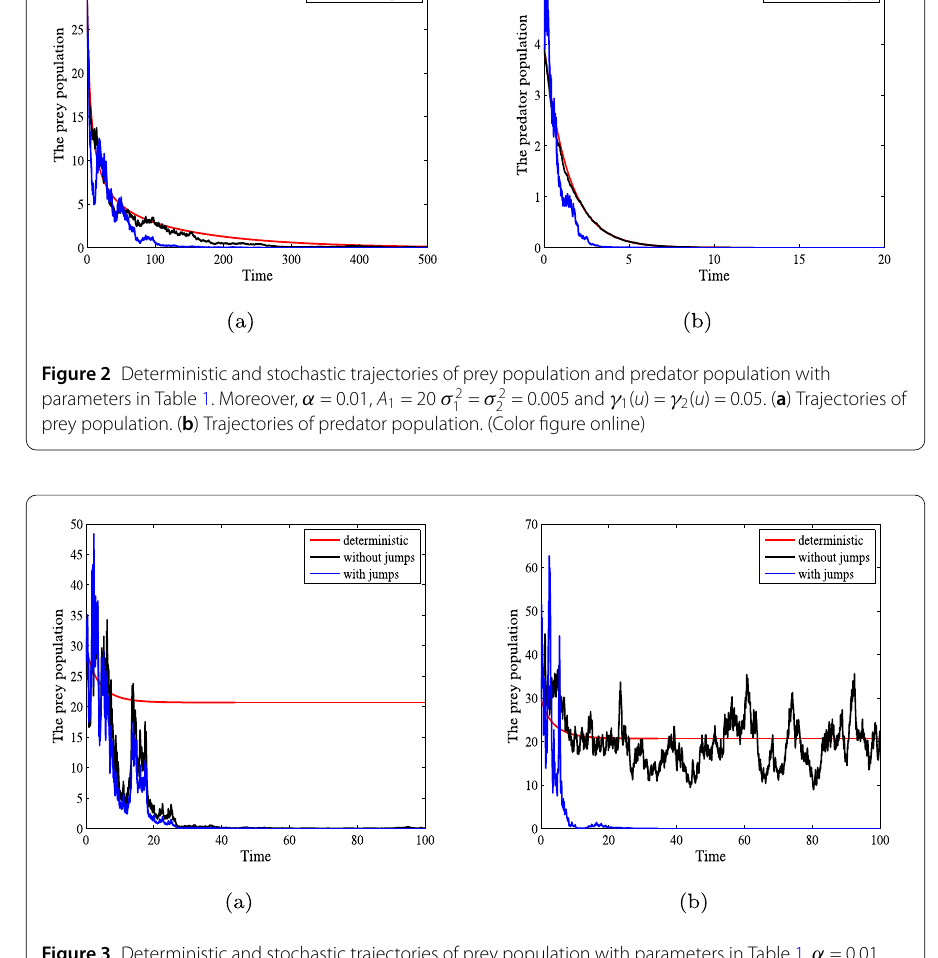
Figure 3 Deterministic and stochastic trajectories of prey population with parameters in Table 1, α = 0.01, A 1 = 0.5 and different intensities of white noise and jumps. ( a ) σ 2 1 = 0.31, σ 2 2 = 0.2, γ 1 ( u ) = 0.1, γ 2 ( u ) = 0.05. ( b ) σ 2 1 = 0.05, σ 2 2 = 0.2, γ 1 ( u ) = 0.5, γ 2 ( u ) = 0.2. (Color figure